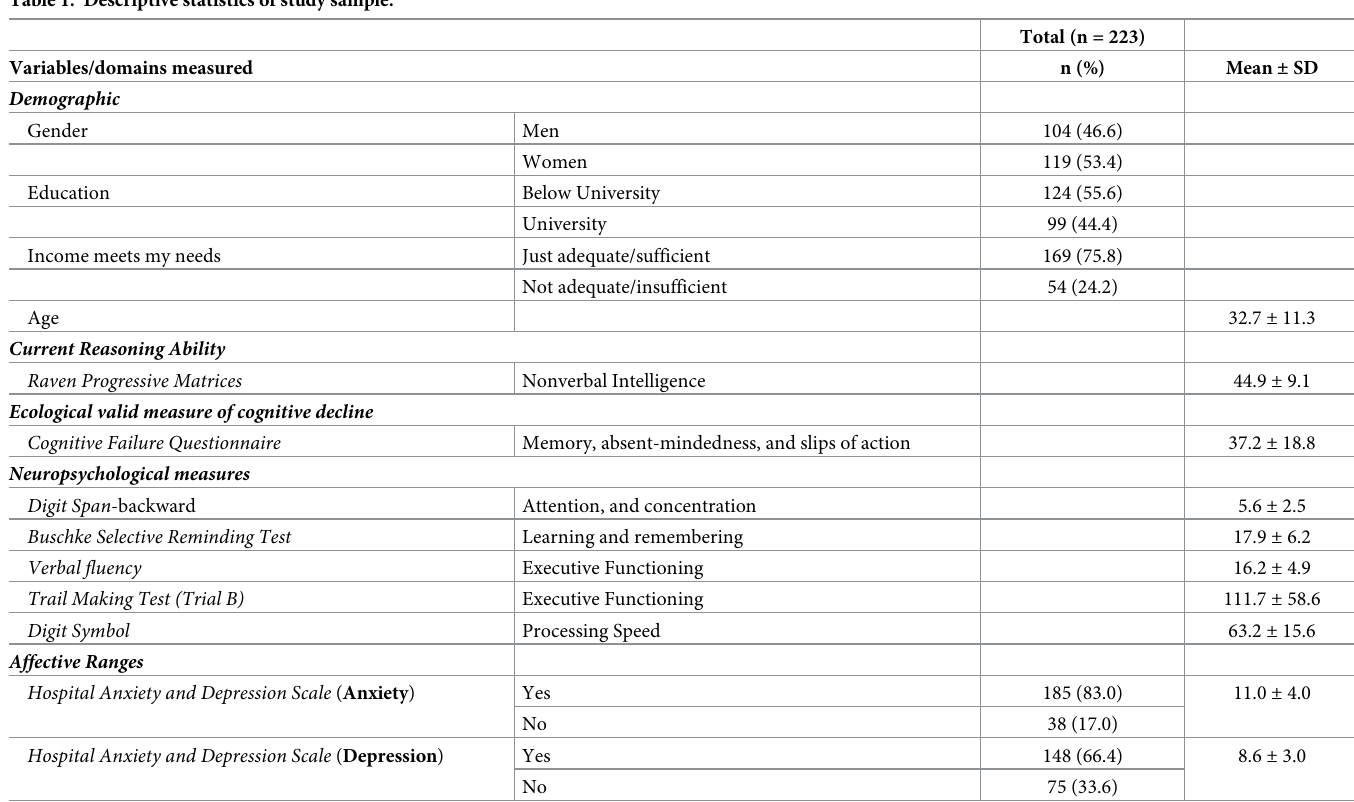
Table 1. Descriptive statistics of study